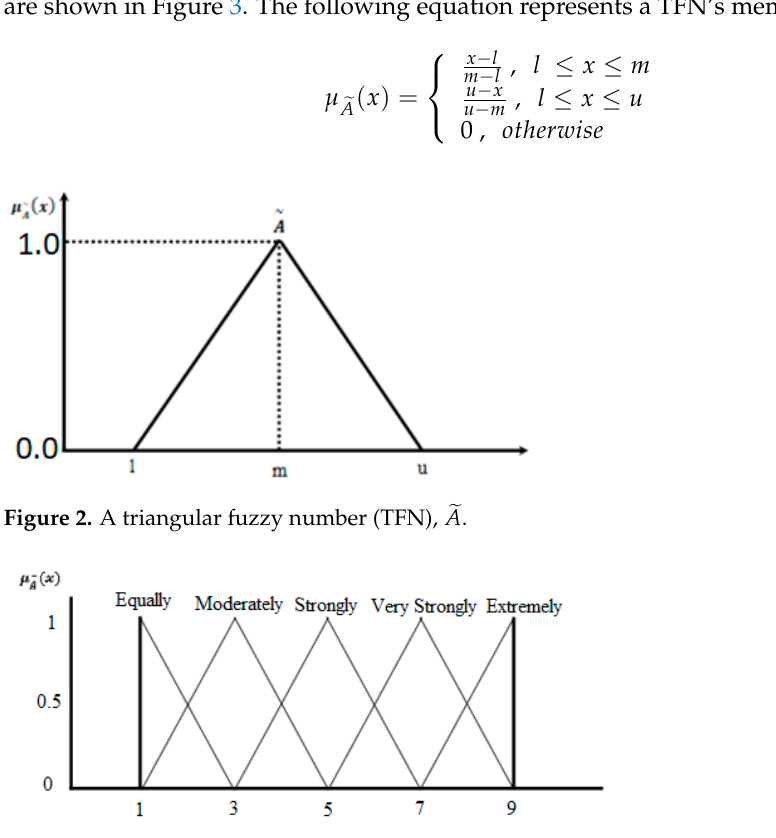
Figure 3. Linguistic variables used for determining importance weight of criteria. The respective lower and upper limit of the fuzzy number (cid:101) A are represented by l and u , with m denoting the fuzzy number’s